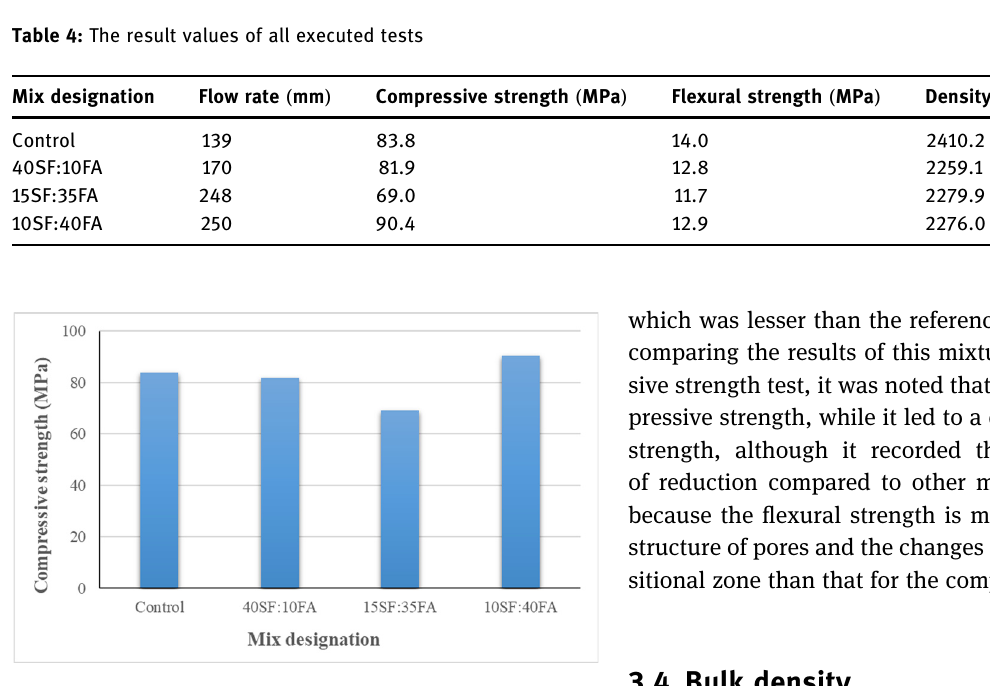
Figure 2: The results of compressive strength of RPC mixtures.